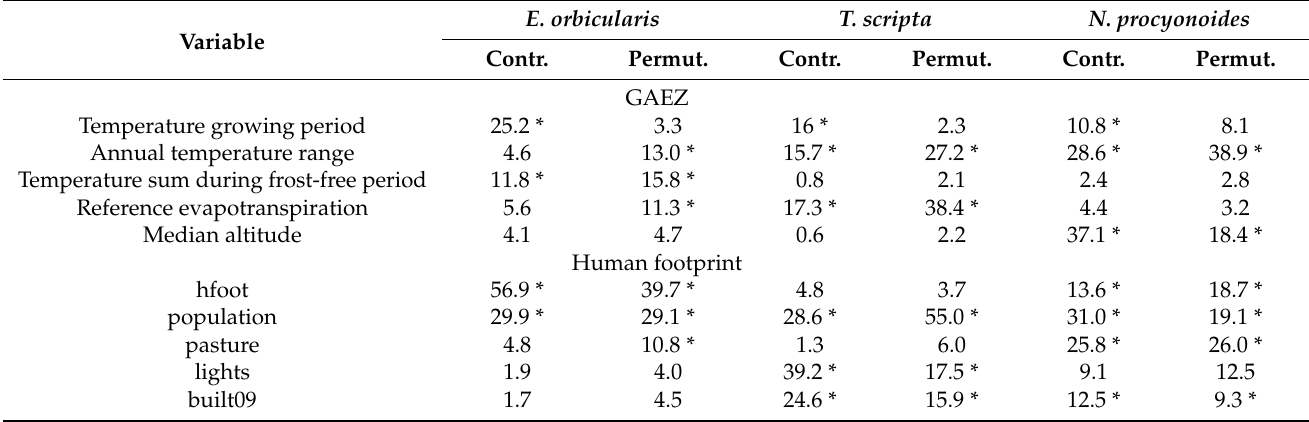
Table 1. Bioclimatic and anthropogenic factors (human footprint, GAEZ), affecting the distribution of three model species (using Maxent). Cases where contribution and permutation were >10% are marked with “*”. “Contr.” and “Permut.” are abbreviated forms of the words “Contribution” and “Permutation”,